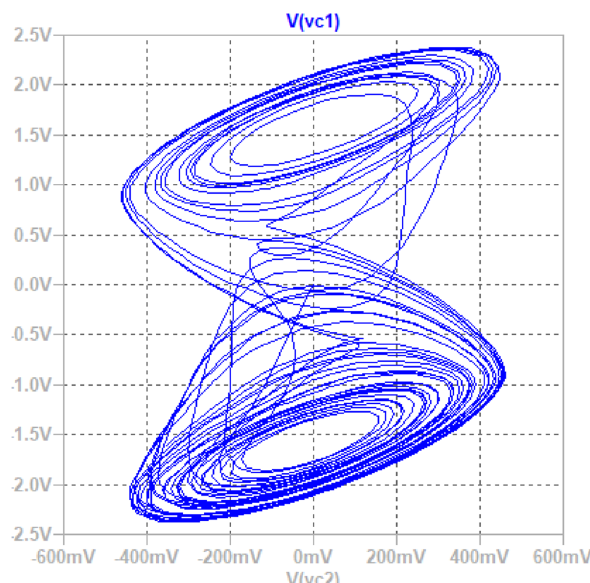
Fig. 14 Double scroll attractor of Chua’s chaotic circuit with memristor value R OFF = 1.6K for T x (U11) and R x